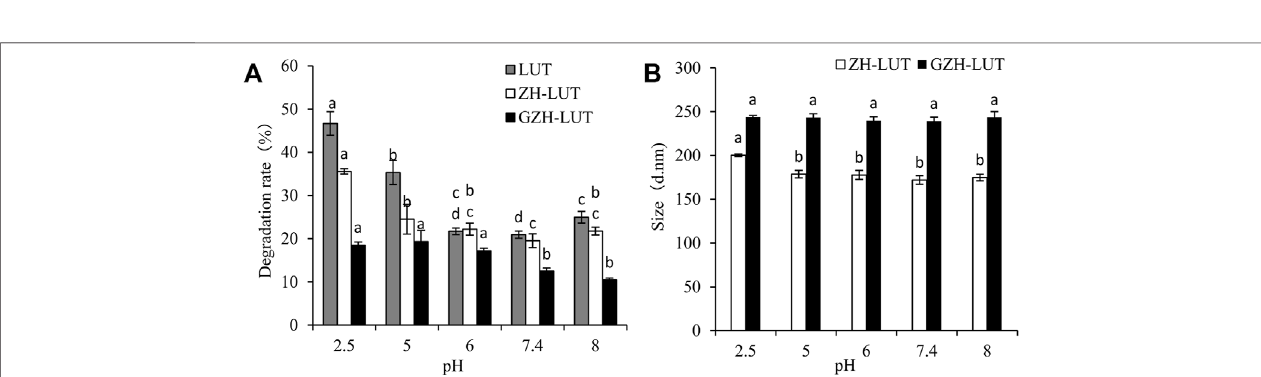
FIGURE 8 | Effects of pH on the pH stability of free lutein, ZH-LUT and GZH-LUT nanoparticles (A,B) .